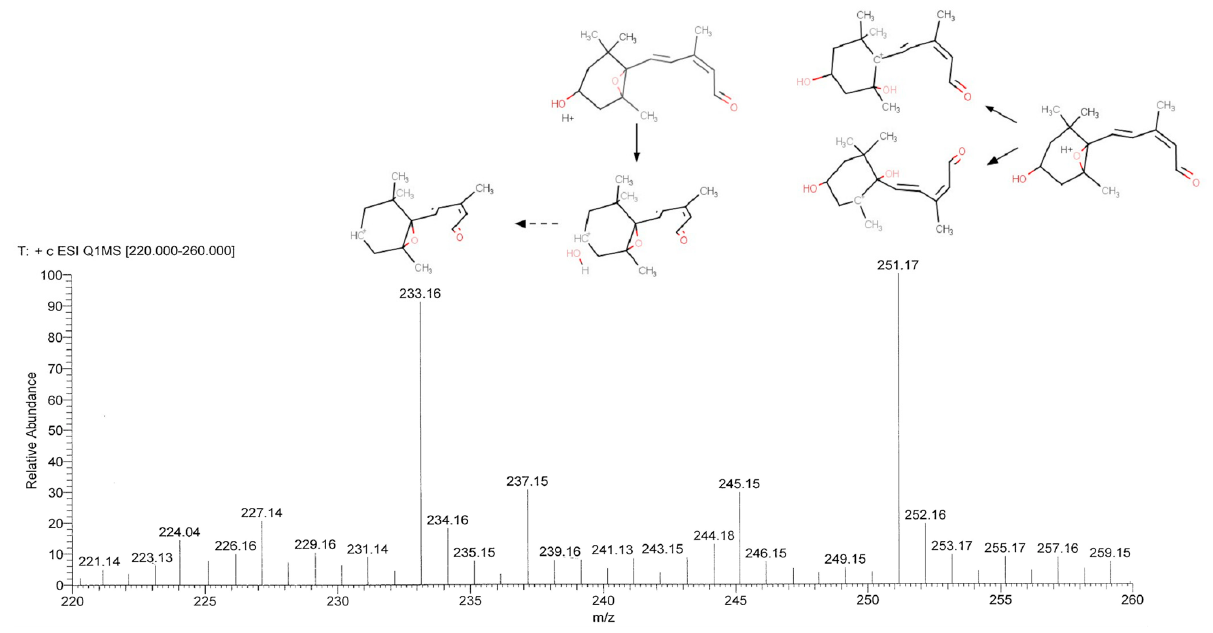
Figure 3. LC-ESI-MS analysis of the (unfragmented) molecule identified as xanthoxal. Two major peaks were observed, with m / z values of 251.17 and 233.16, corresponding to the protonated molecule and its dehydrated form, respectively. The putative structures (based on the cis , trans -xanthoxal isomer) above each main peak represent the proposed identification of the molecule.